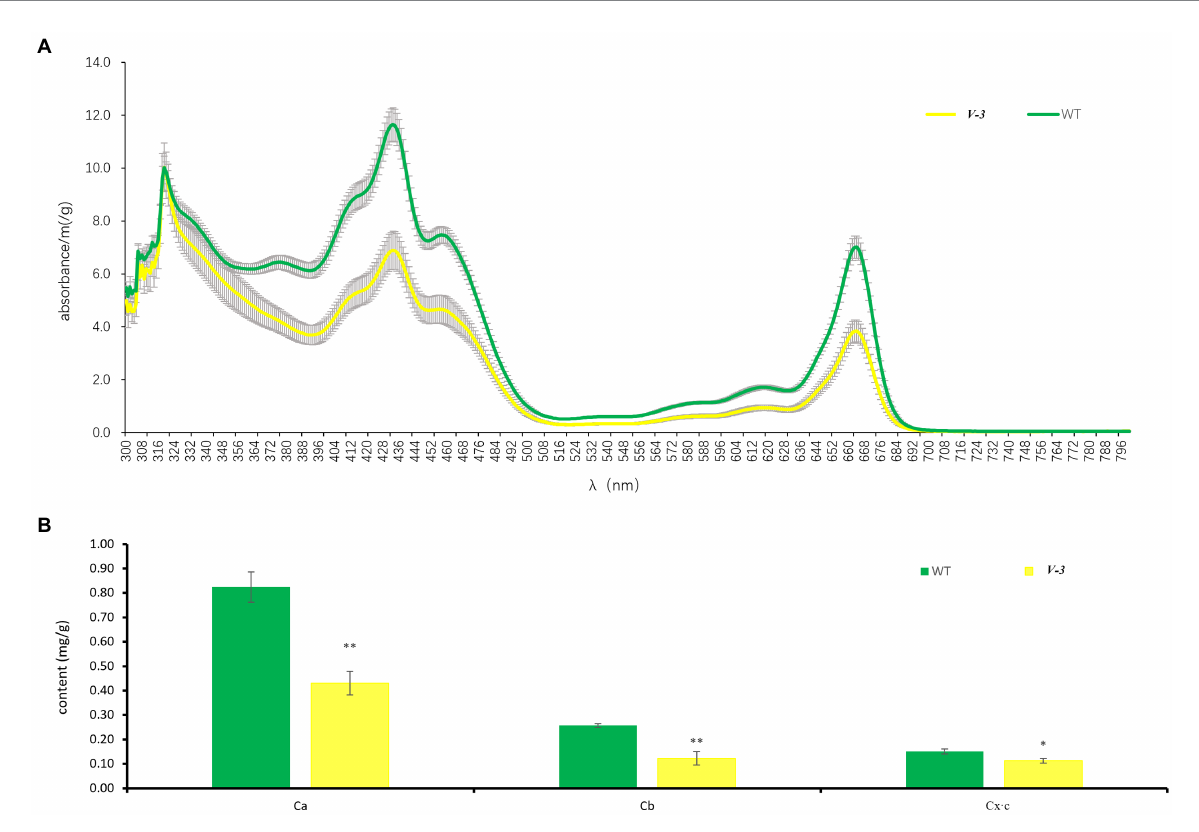
FIGURE 2 Leaf pigments of v-3 and the WT. (A) The spectral scans of leaf pigments of v-3 and the WT. (B) Chlorophyll a, chlorophyll b, and carotenoid content of v-3 and the WT. Data are the mean ± SD. Error bars represent the SD of five independent replications. SD, standard deviation; WT, wild type. * p < 0.05. ** p <